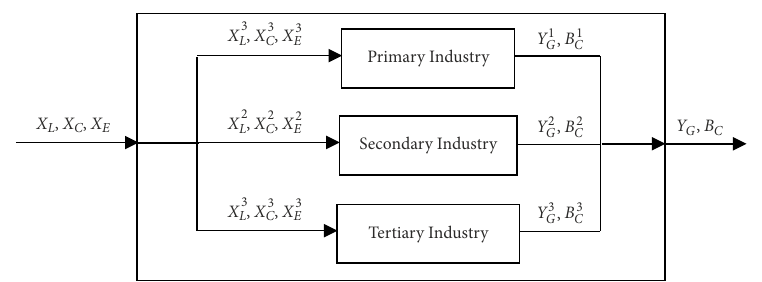
Figure 2. Economic system of provinces in